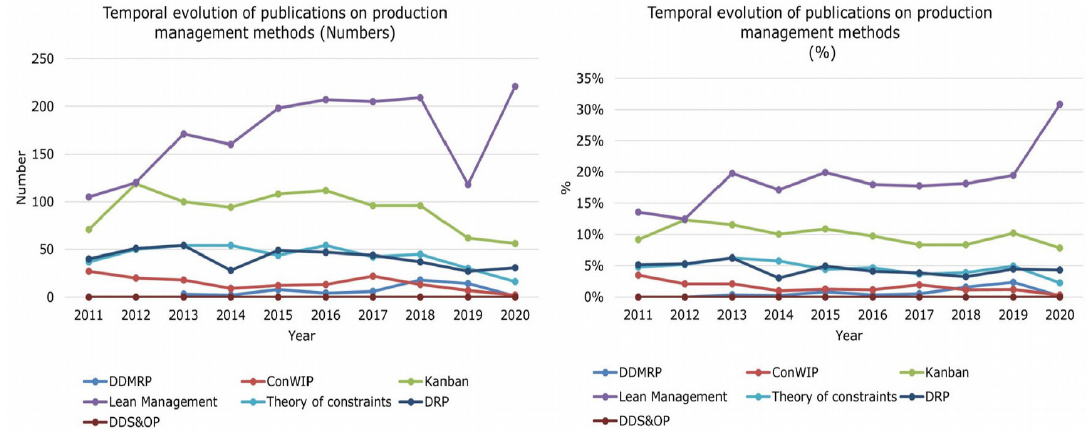
Figure 2. Results of Sub-component 1-1: The temporal evolution of DDMRP and the publications on other